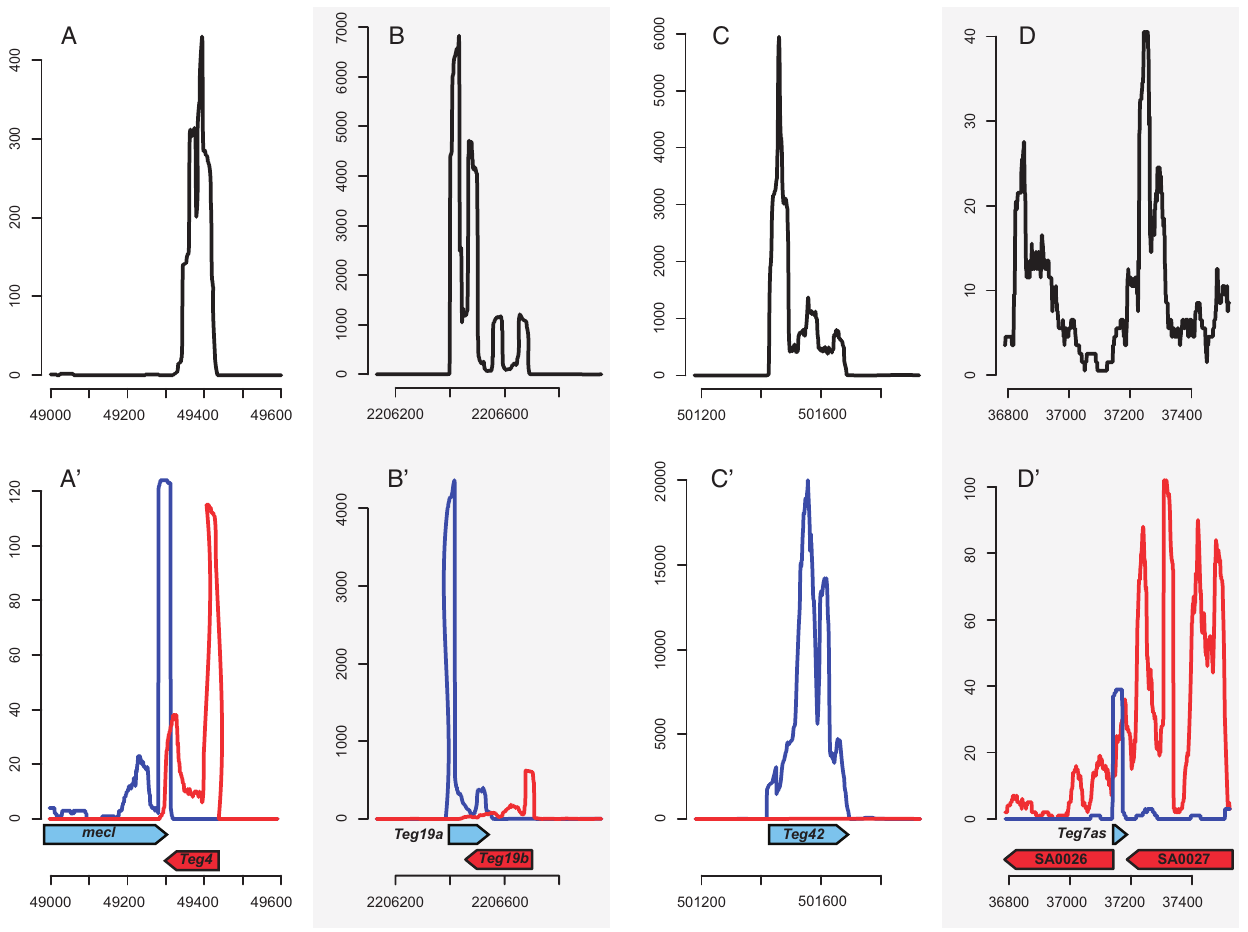
Figure 1. Visualization of different categories of transcripts detected and oriented by HTS RNA-Seq visualized in Artemis genome analyzer browser. The top panels (A–D) display the shape of signals obtained in the detection experiment. The lower panels (A 9 –D 9 ) shows the corresponding signals obtained during the orientation experiment. The X-axis corresponds to N315 genomic coordinate and Y-axis symbolizes the normalized coverage. Transcripts expressed on the forward strand are depicted in blue whereas transcripts expressed on the reverse strand appear in red. The vertical axis indicates local sequencing coverage. The arrows represent the position of annotated ORFs deduced from N315 genome sequence and the position of Teg identified in our study. Panels A–C presented various intergenic signals and D shows a typical antisense signal.